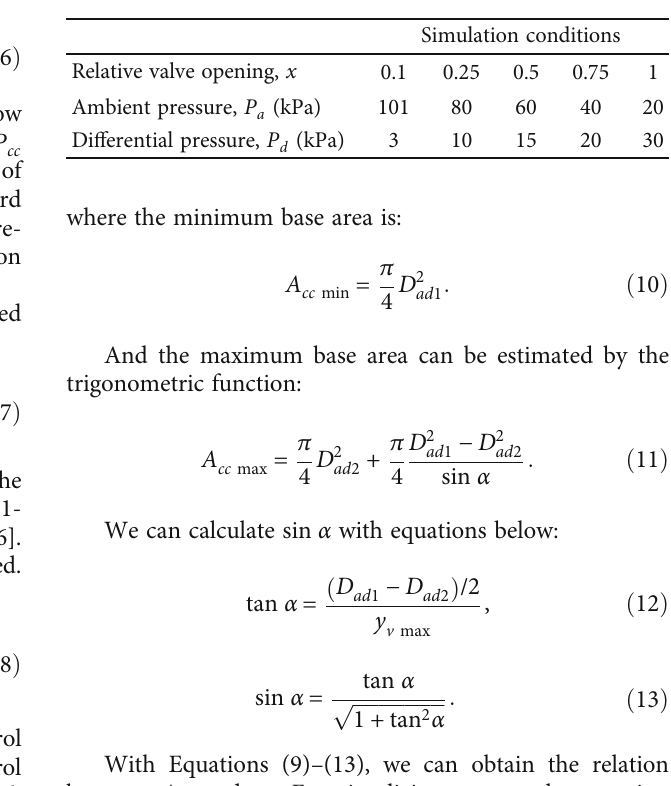
Figure 6: Schematic diagram of the moving poppet. Table 1: Permutation of valve opening, ambient pressure, and di ff erential